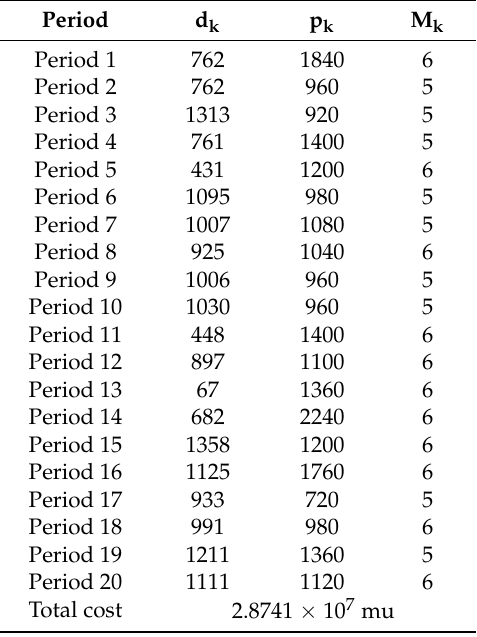
Table 7. Case 2: Production plan for individual maintenance policy.